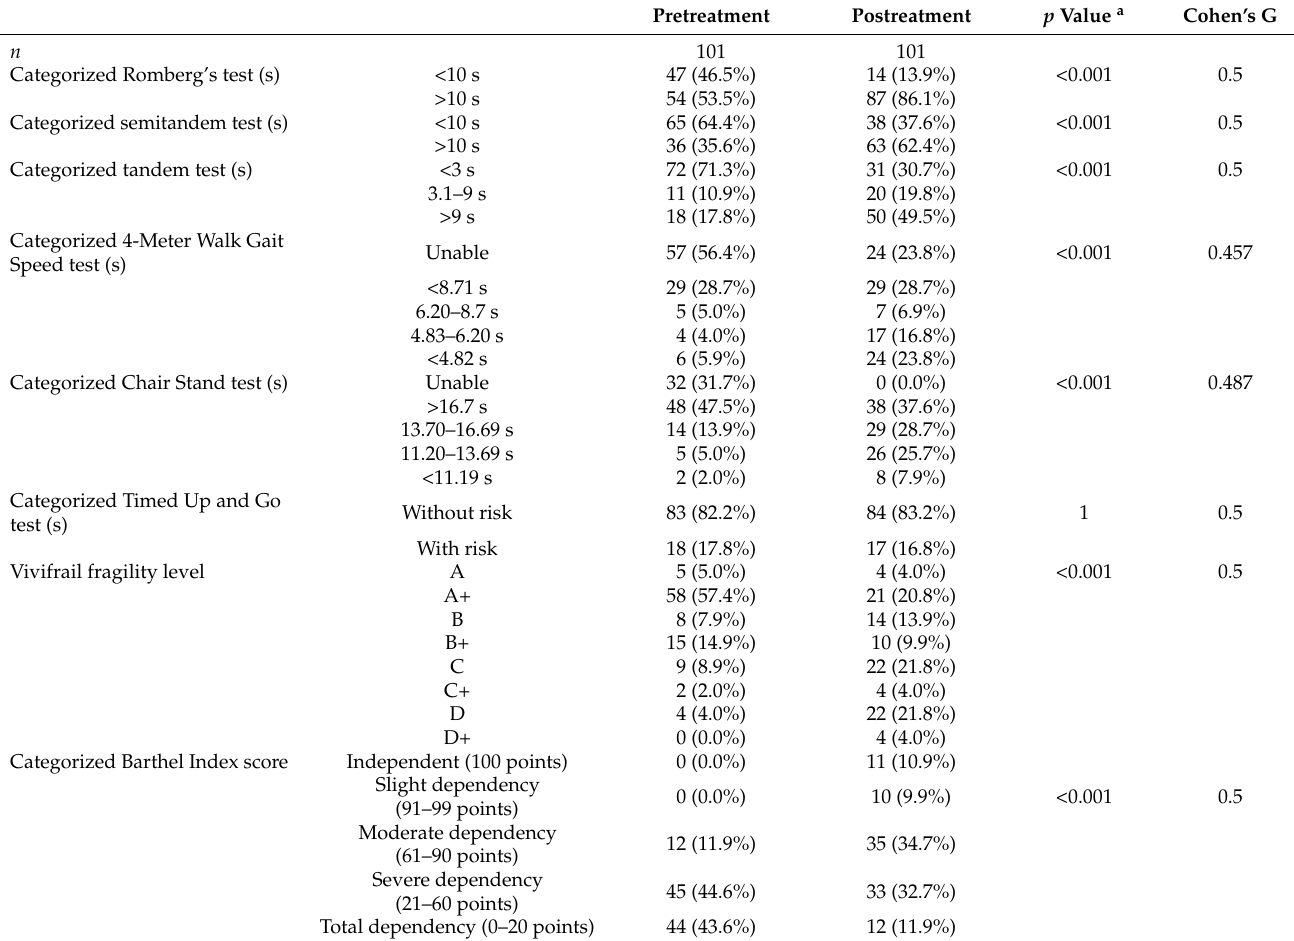
Table 3. Qualitative outcome variables.